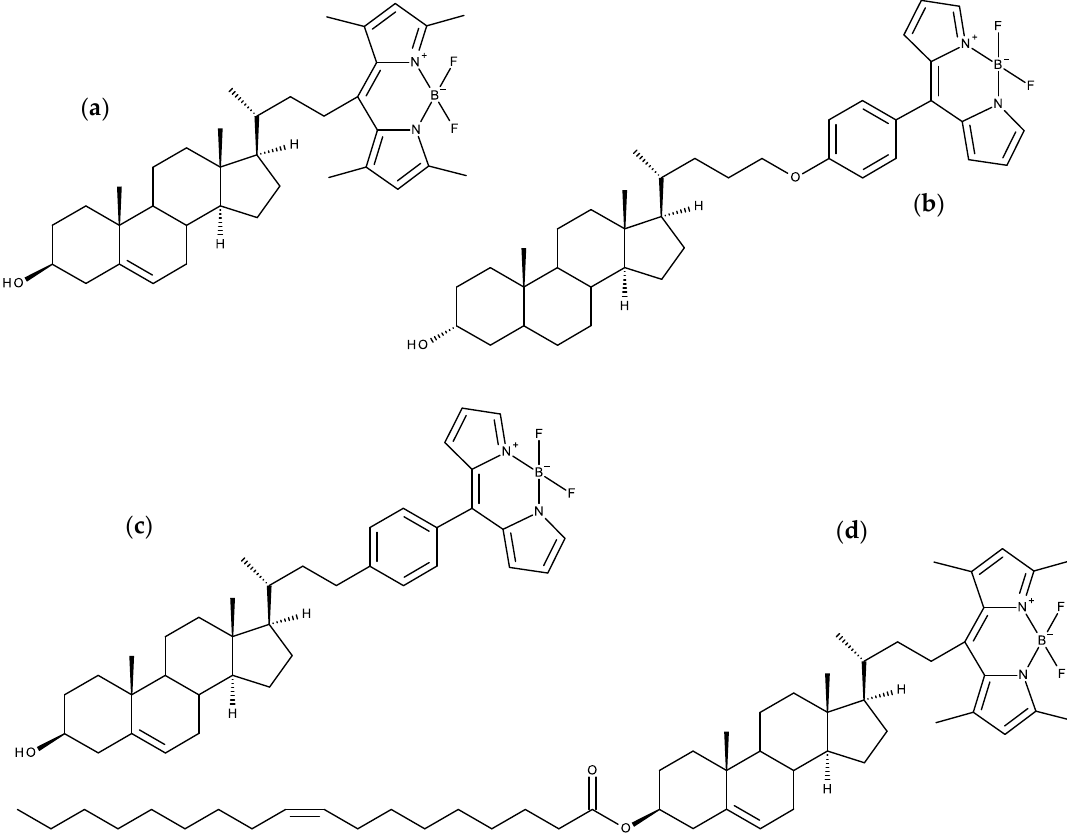
Figure 15. Structures of BODIPY side-chain labeled sterols. ( a ) TopFluor ® Chol; ( b ) phenyl-BODIPY litocholate-derived rotor with ether linkage; ( c ) phenyl-BODIPY Chol rotor with alkyl linkage; ( d ) TopFluor ® cholesteryl oleate ester (BODIPY-CE).